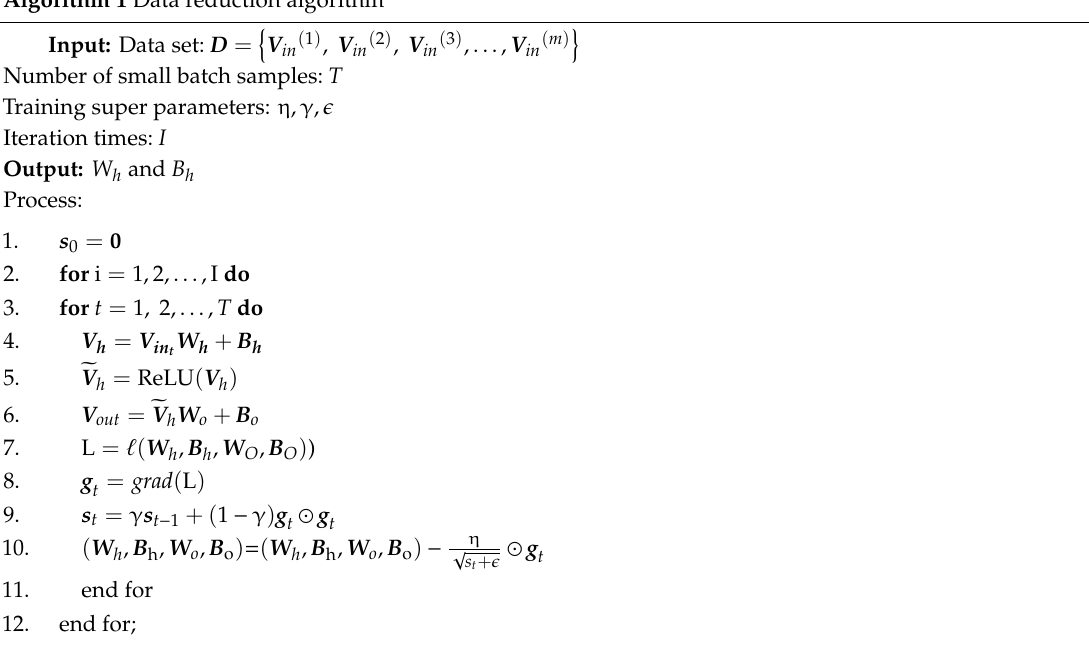
Algorithm 1 Data reduction